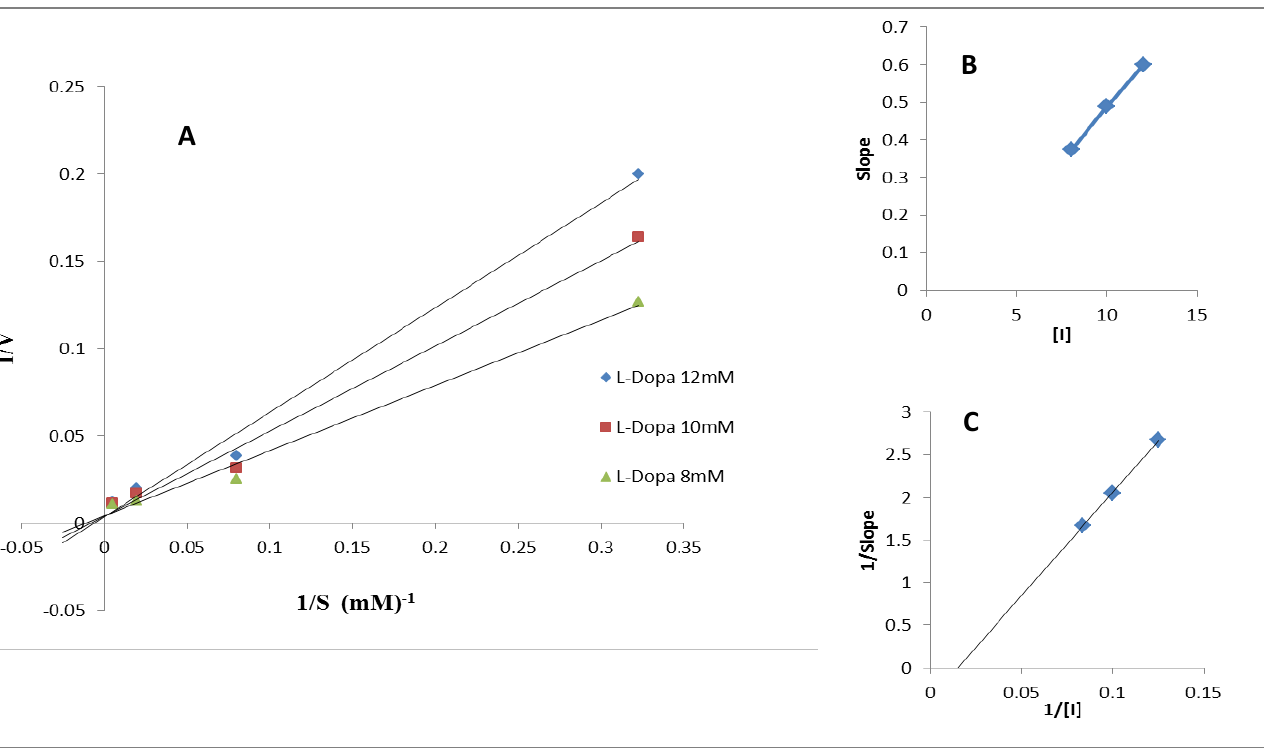
Figure 5: Kinetic properties of L. esculentum Mill (var. Hausa) (A) Lineweaver-Burk plot for the inhibition of var. Hausa (B) Replot of the slope of the Lineweaver-burk plot versus inhibitor concentration (C) 1/ΔSlope versus